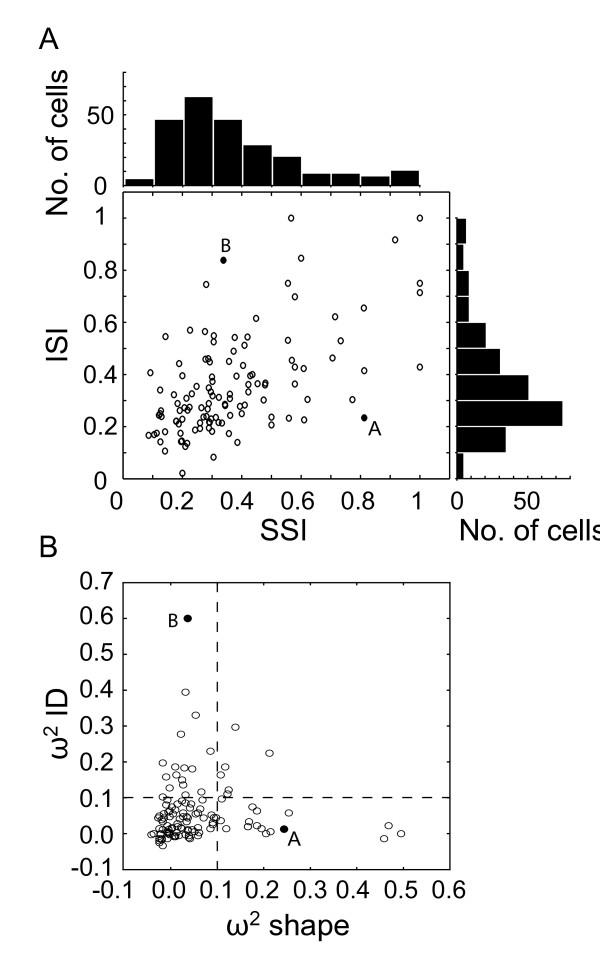
Selectivity indices. (A) Scatter plot of the illumination selectivity index (ISI) as a function of the shape selectivity index (SSI), with their respective distributions plotted on the top and right sides of the scatter plot. The median values of SSI and ISI distributions are 0.30 and 0.31 respectively. The black dots represent the neurons illustrated in Figures 4A (SSI = 0.81, ISI = 0.23) and 4B (SSI = 0.31, ISI = 0.83). (B) The ANOVA based ω2 index for illumination direction plotted as a function of the ω2 index for shape. The black dots represent the neurons illustrated in Figures 4A & B. Dashed lines represent the thresholds of 0.10 that we used to determinate that a cell is highly selective to shape or illumination direction.